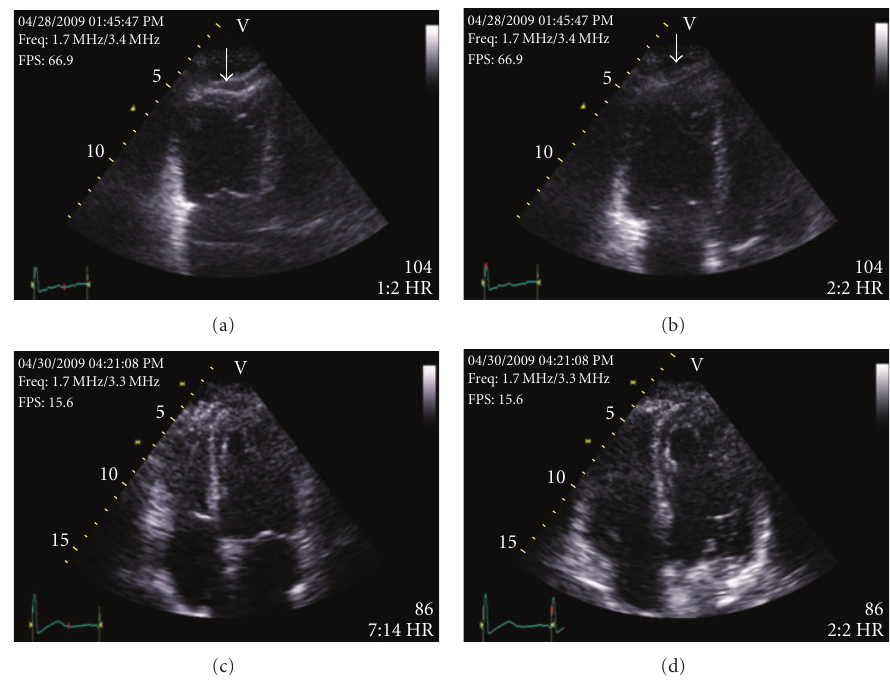
Figure 2: Prethrombolytic therapy transthoracic 2D echocardiogram showing marked hypokinesia of the right ventricle mid-free wall in end-systole (a) and end-diastole (b) while the right ventricle apex is spared (arrows). Postthrombolytic therapy transthoracic 2D echocardiogram showing complete resolution of right ventricular mid-free wall hypokinesia in end-systole (c) and end-diastole